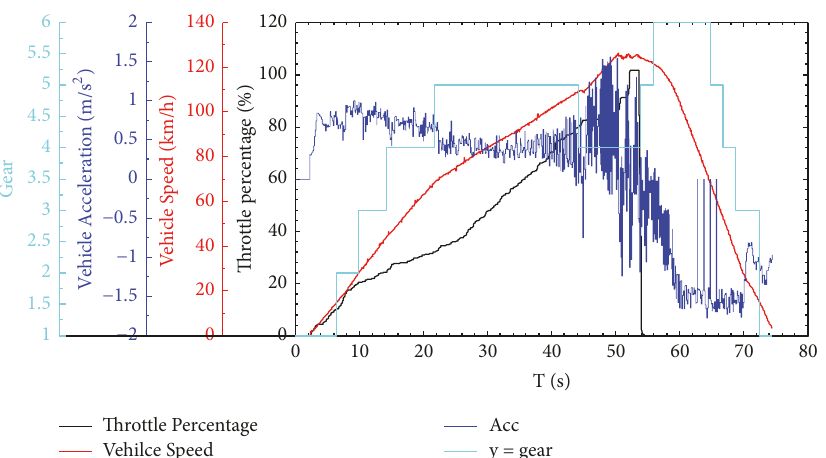
Figure 12: Road test